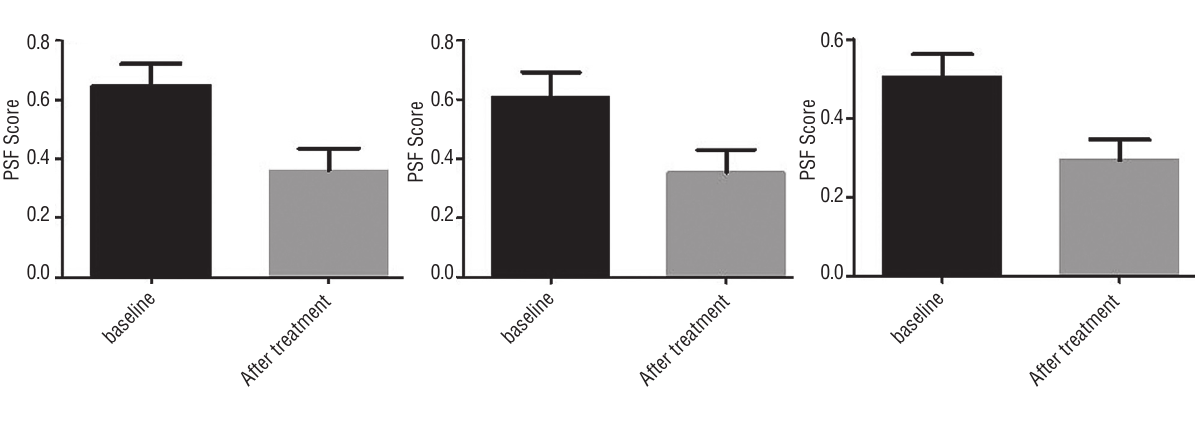
Figure 1 - Graphs to show mean PSF score and standard deviation in each PSF category for the 26 patients in the study. PSFs above 0.5 are considered